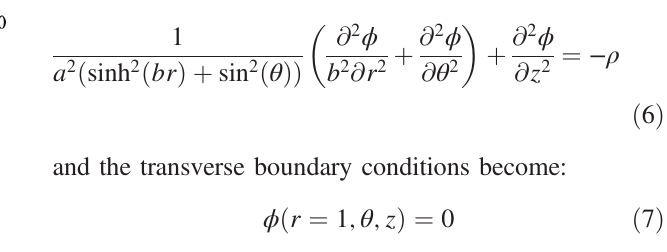
FIG. 1. A schematic plot of an elliptical coordinate system. The red line defines an elliptical boundary. The length of the major axis is given by 2 a cosh ð b Þ and the length of the minor axis is given by 2 a sinh ð b Þ